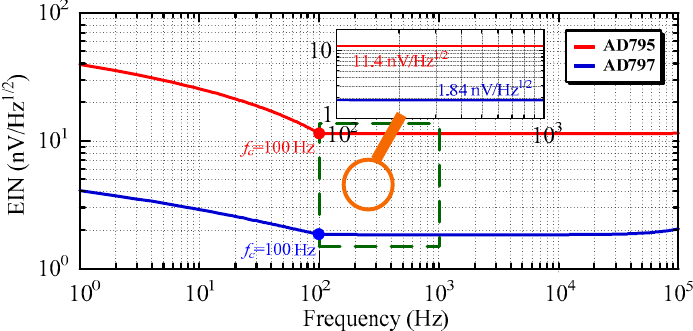
Figure 9. Equivalent input noise calculated using AD797 and AD745 .